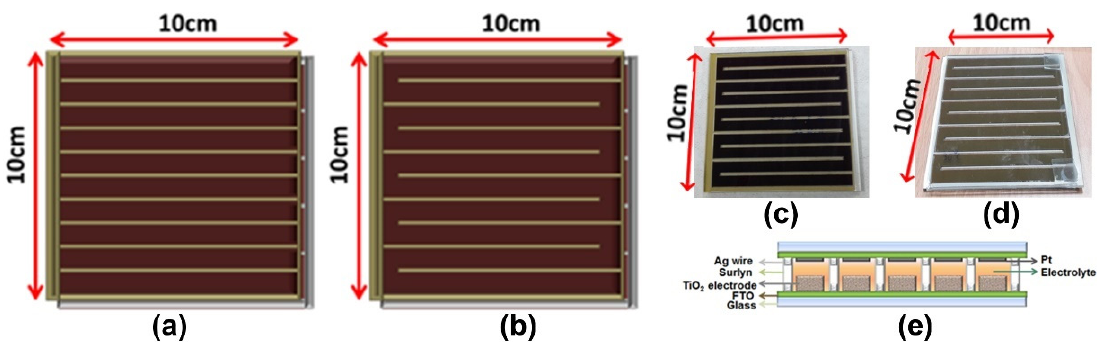
Figure 1. The sketch of DSSC module structure of ( a ) column-shaped (C-DSSC) module and ( b ) S-shaped SDDC (S-DSSC) module. The photo of ( c ) front and ( d ) rear side of 10 cm × 10 cm S-DSSC. ( e ) The cross-section sketch of DSSC module.